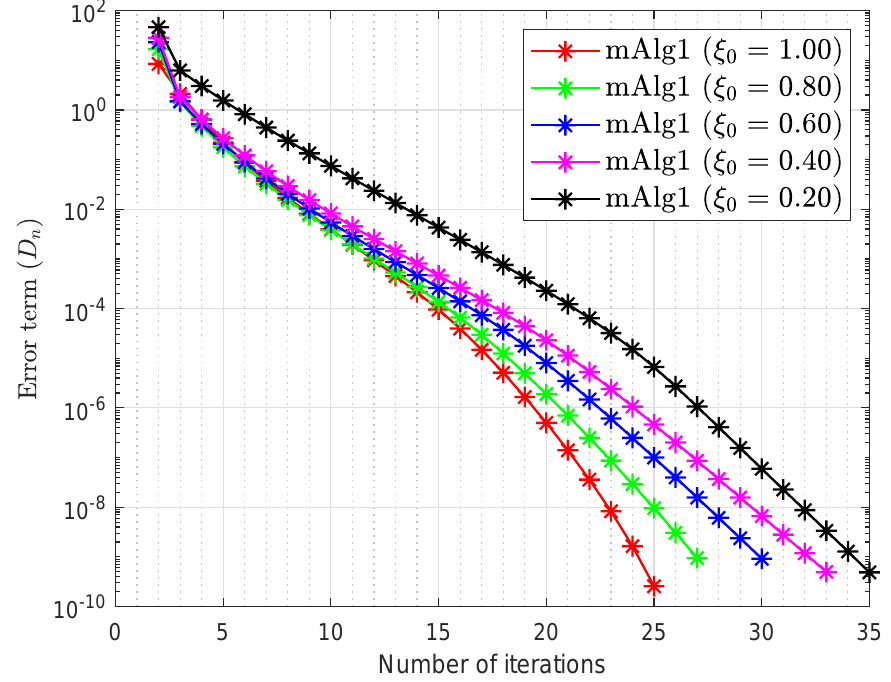
Figure 2. Example 1: numerical behaviour of Algorithm 1 by letting different options for ξ 0 , while m =